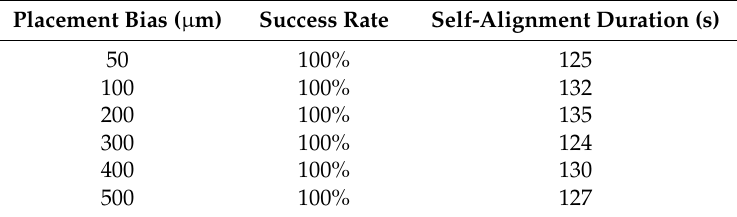
Table 2. Influence of placement bias on capillary self-alignment.